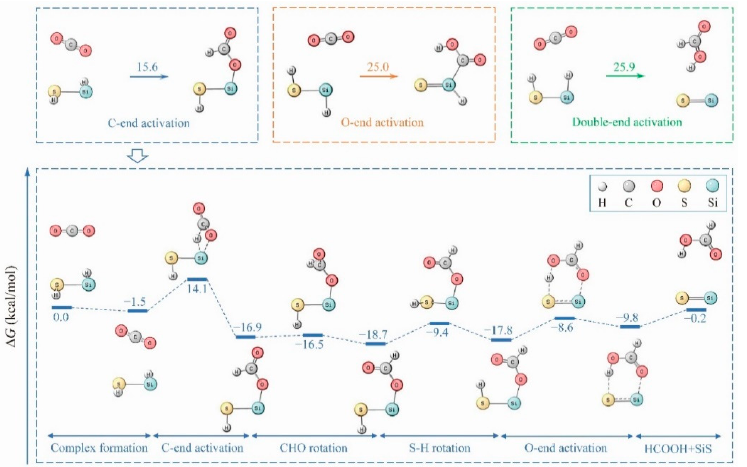
Figure 4. Optimal path obtained for the HSiSH + CO 2 reaction; the activation energies for different